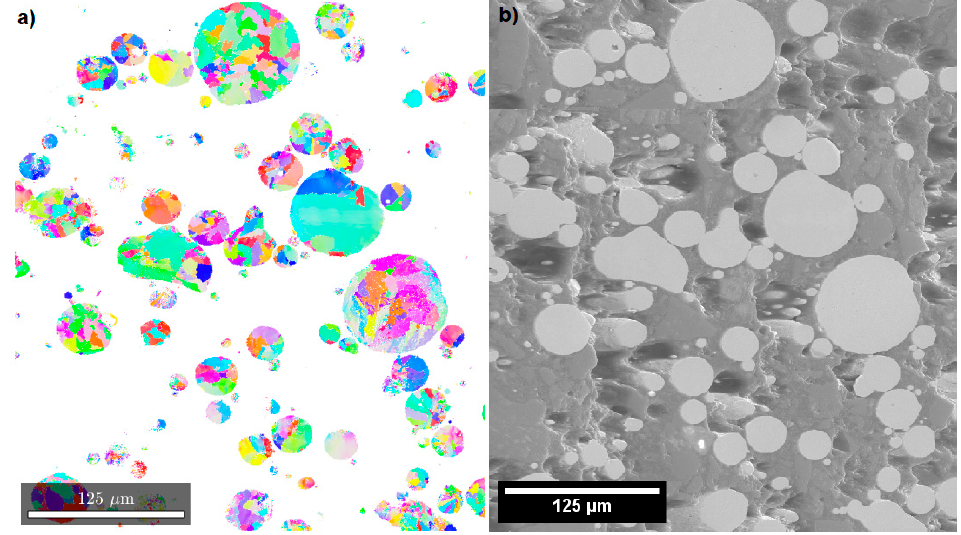
Figure 2. Electron backscattered diffraction (EBSD) map of powder cross-section prior to coating ( a ), with the corresponding secondary electron image ( b ).